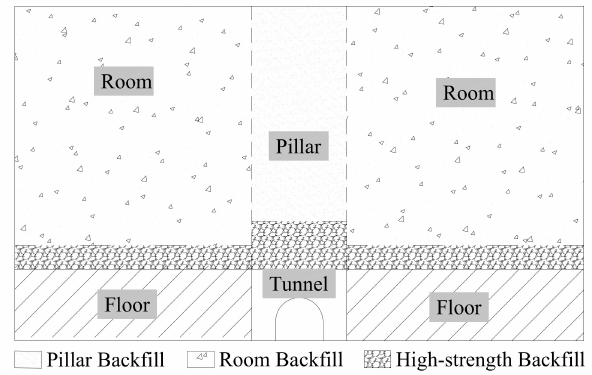
Figure 14. Backfill stopes